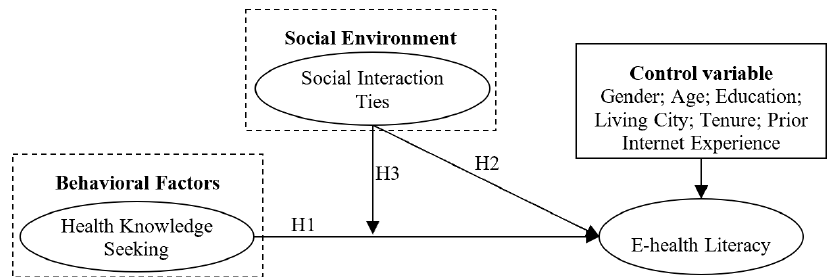
Figure 1. Hypotheses and research model. Note: H1, H2, and H3 respectively short for Hypothesis 1, Hypothesis 2, and Hypothesis